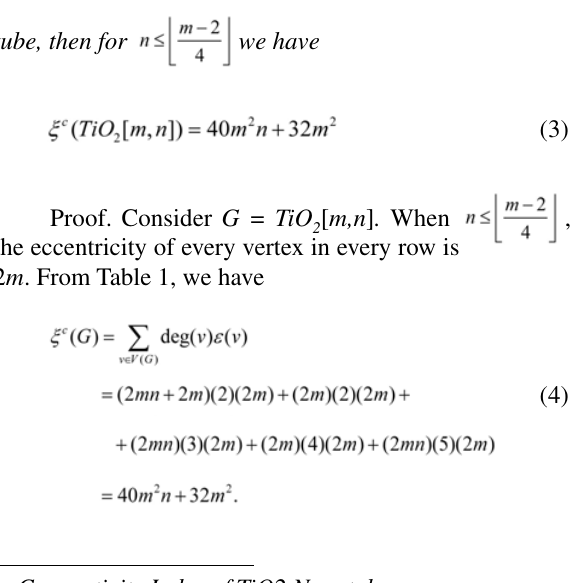
The molecular graph of TiO 2n+2 rows and m columns. For each i th row and j th co- lumn, we label the vertices of TiO v , x and y as shown in Figure 2. ij ij ij